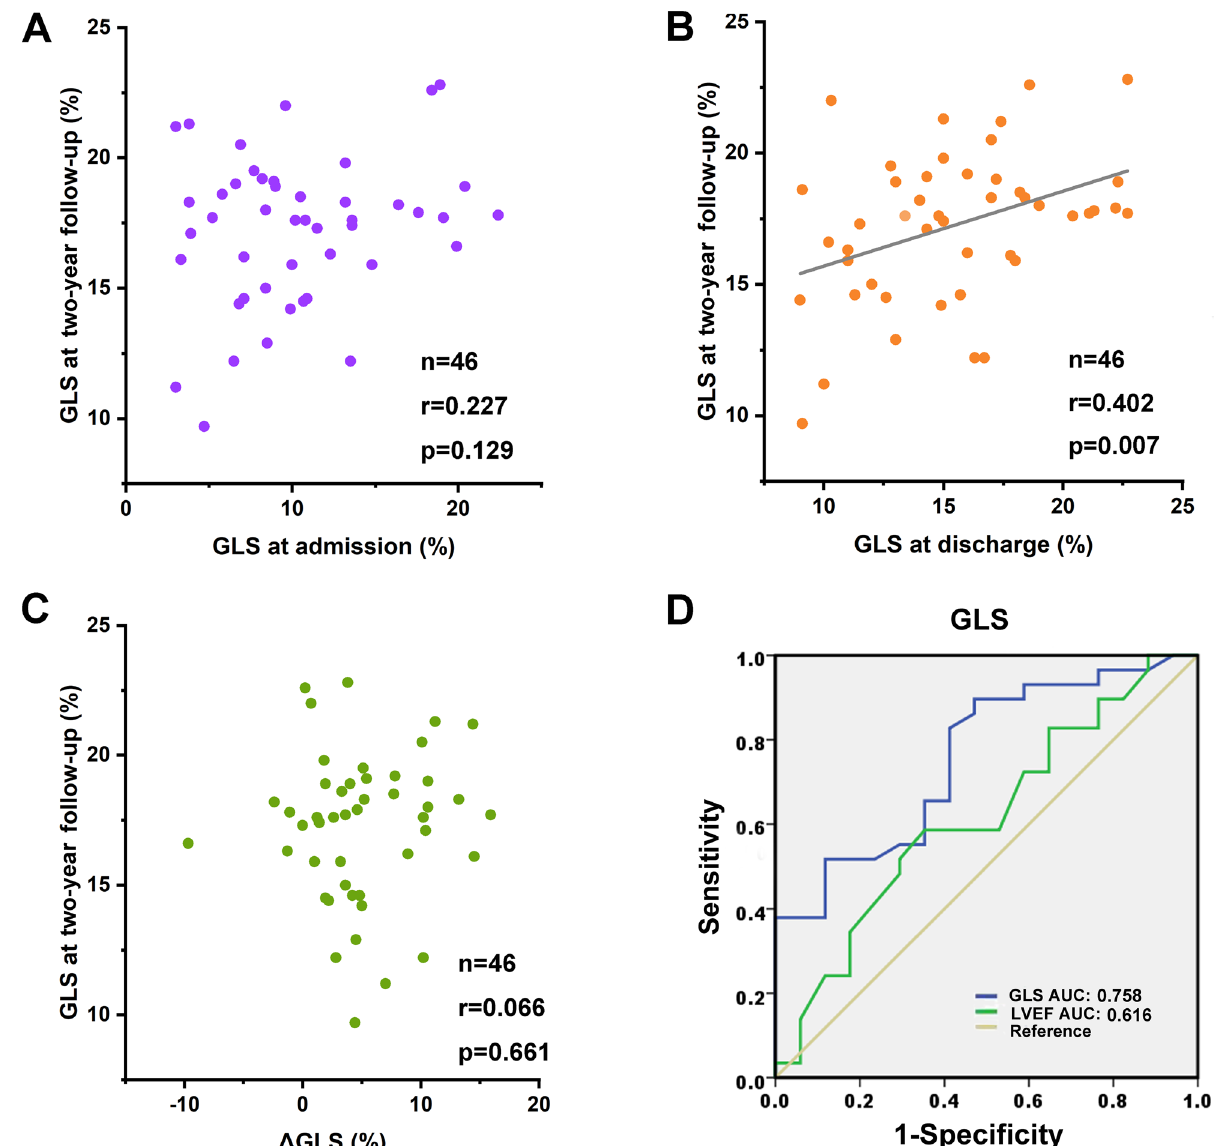
Figure 3. Dot plots of GLS at discharge, at admission and delta GLS (the difference of GLS between admission and discharge) in relation to GLS at 2-year follow-up. There was a significant correlation for GLS at discharge ( B ), but not GLS at admission ( A ) and delta GLS with GLS at 2-year ( C ). ( D ) Receiver operating characteristic curve analysis for the value of GLS at discharge to predict the GLS normalization at two years. GLS < 13.2% could predict the GLS normalization of (> 17%) with a sensitivity 82.2% and specificity of 58.8% (AUC: 0.758). AUC = area under curve. http://m. qpic. cn/ psc?/ V53wp KJ24F 3mOO0 15TIE 1dJF3 728Qw lj/ ruAMs